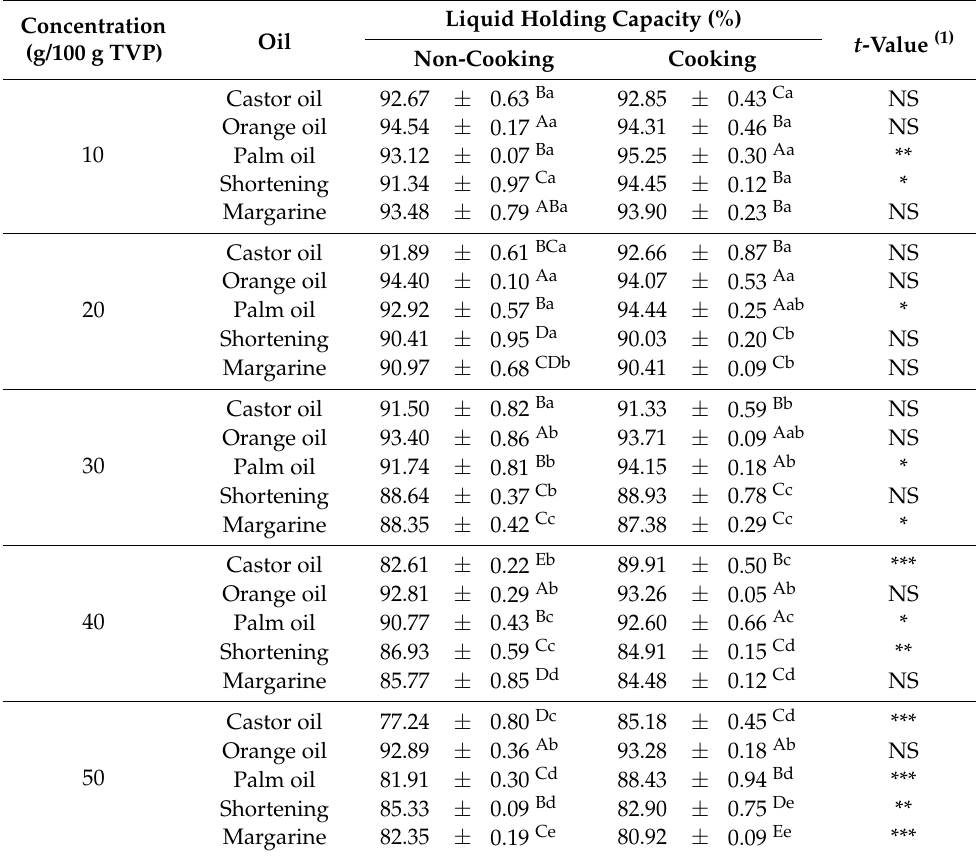
Table 5. Liquid holding capacity (%) of meat analog supplemented with different types or amounts of vegetable oils stored at 25 ◦ C